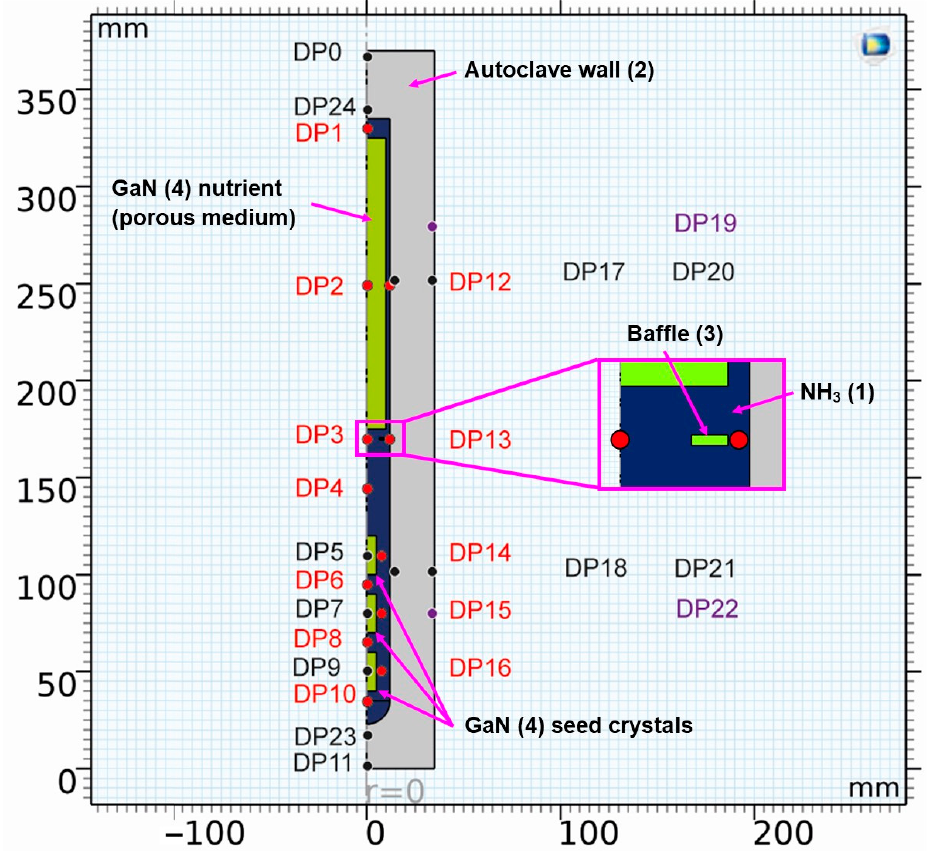
Figure 1. Geometry of the model with location of domain point probes (see Table 2 for coordinates thereof and for a description of the chosen locations). The color coding of the labels is as follows: probes in the fluid (red), probes in solids (black and purple), and probes at the location of control thermocouples in an experimental setup (purple). The components are also labeled, including a number that refers to the material (see Tables 3–5 for further information on materials).